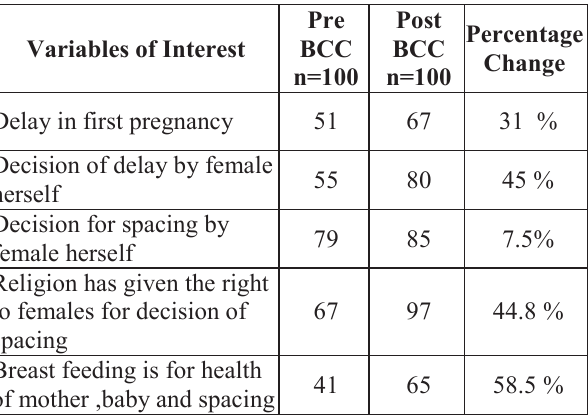
Table-3: Percent Point Change in perceptions before and after BCC